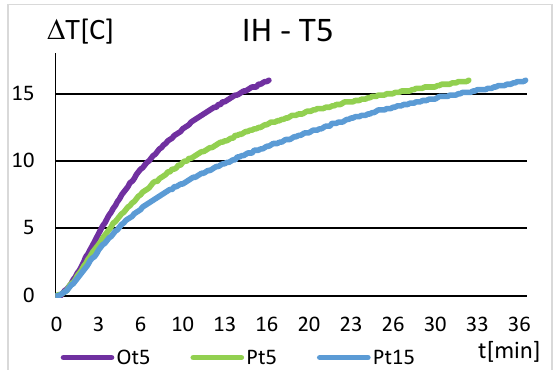
Figure 22. Slide plate increment temperature from the side of stock-rail (T5) in induction heating IH for: Ot5 — the switch-rail moved away from the stock- rail and the ambient temperature −5 ° C; Pt5 — switch-rail in contact with the stock- rail and the ambient temperature −5 ° C; Pt15 — switch-rail in contact with the stock-rail and the ambient temperatur e −15 ° C.